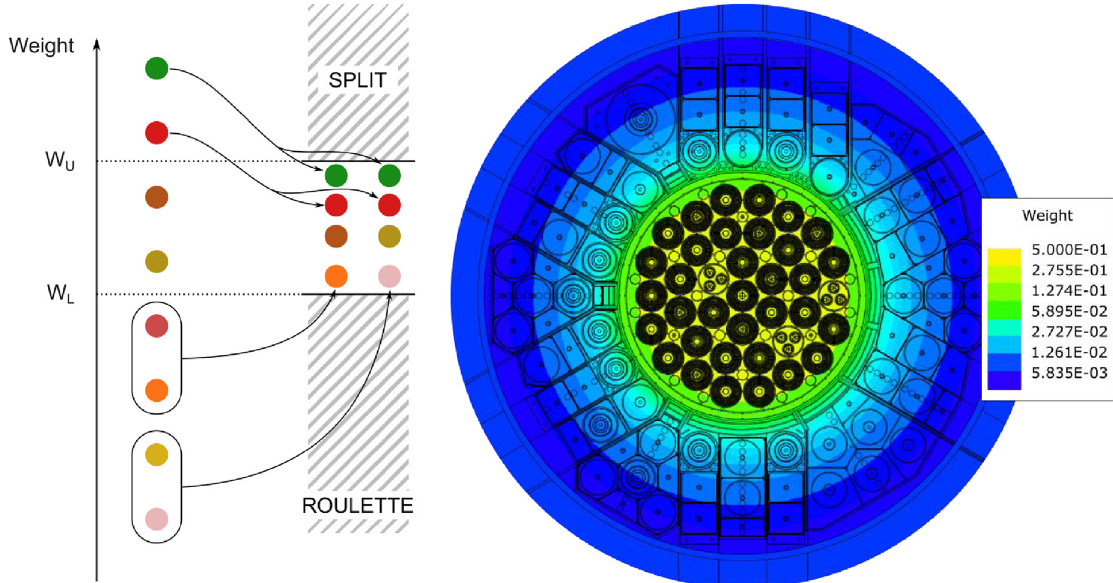
Fig. 3. Weight ponderation scheme on the left and neutron fl ux weight map obtained with the MCNP generator on the right, for neutron energy from 5 MeV to 20 MeV.